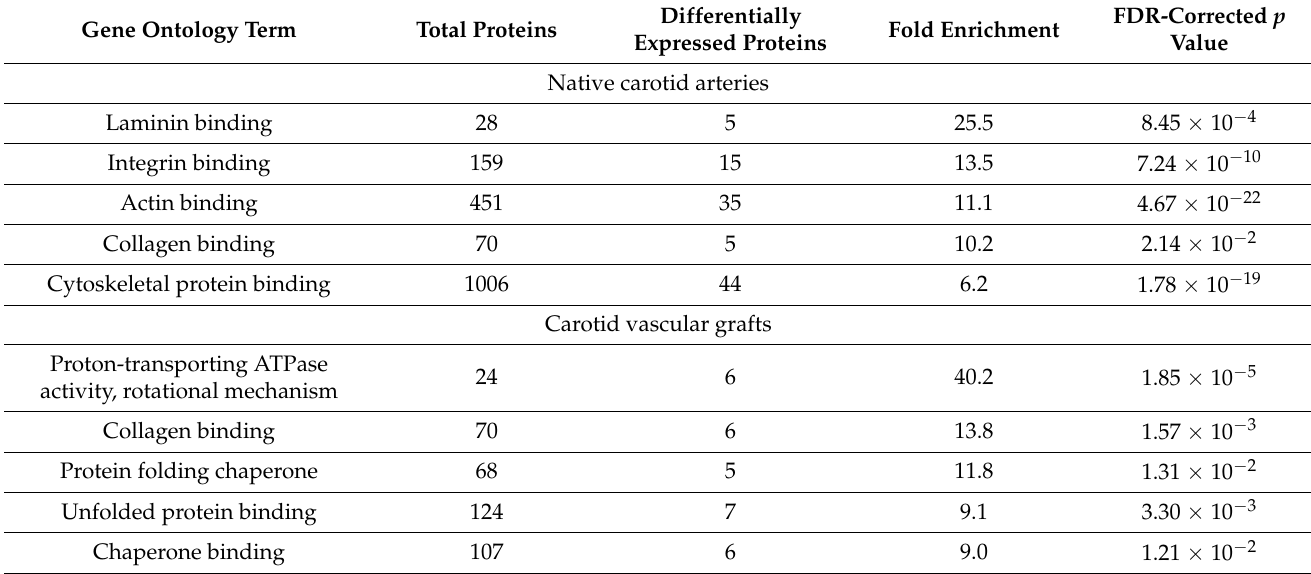
Table 4. Molecular functions of proteins which are upregulated in either native carotid arteries or TEVGs (annotated according to the Gene Ontology Molecular Function database).